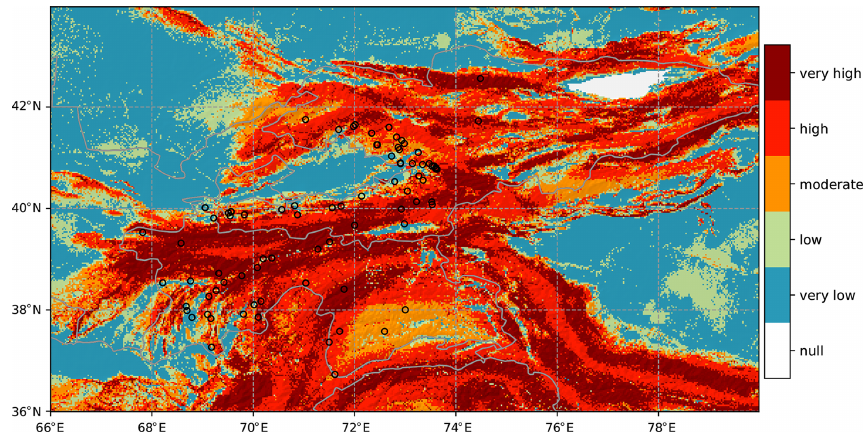
Figure 8. Non-climatic landslide susceptibility map computed using slope, geology, fault zones, road networks, and forest loss developed by Stanley and Kirschbaum (2017). Black circles: landslide events from the GLC and the GFLD. Topographic shading is based on DEM data from SRTM.